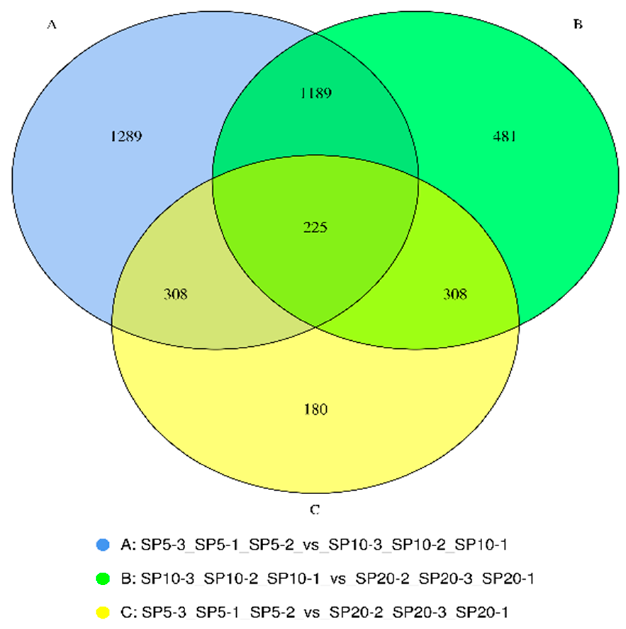
Figure 1. The number of differential genes between different groups (SP5: flow velocity 5 cm/s; SP10: flow velocity 10 cm/s; SP20: flow velocity 20 cm/s; “ − 1, − 2, − 3” indicates three parallel samples of the same experimental group).